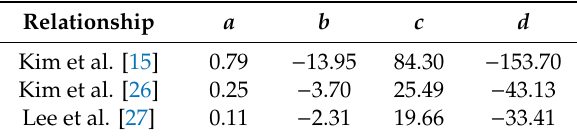
Table 2. Coe ffi cients of cubic polynomial relationships between volumetric unfrozen water content and relative